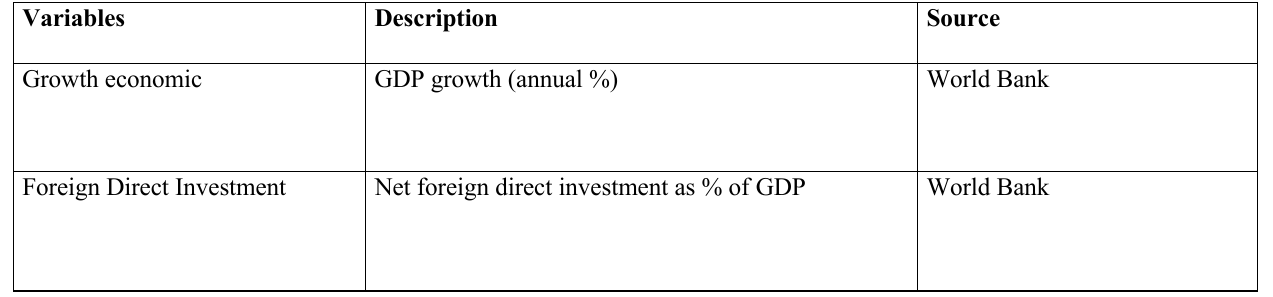
Table 1. Description of variables and data